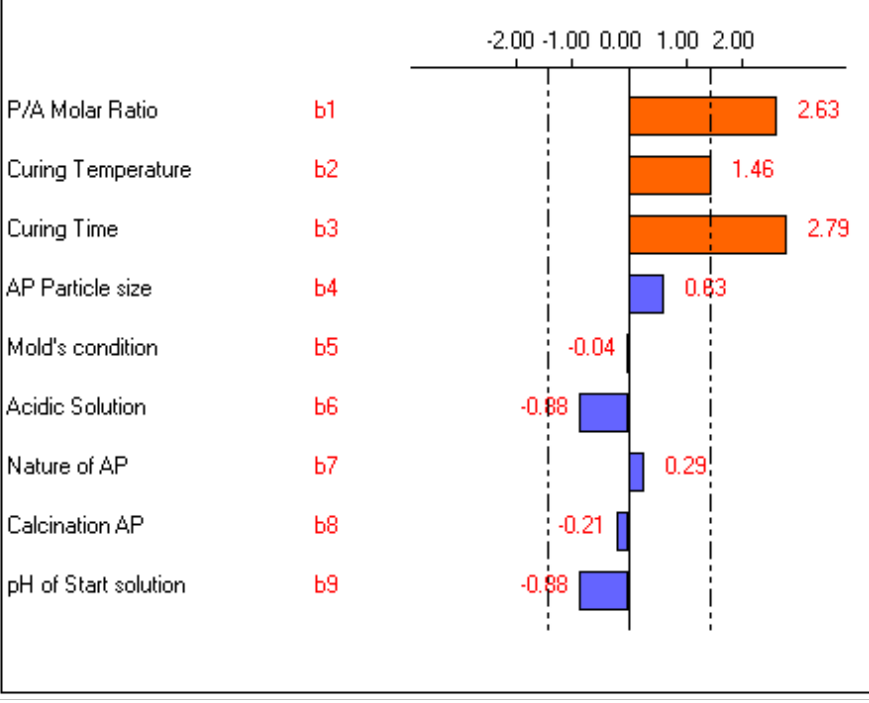
Figure 3. Effects bar graph of Plackett – Burman design.